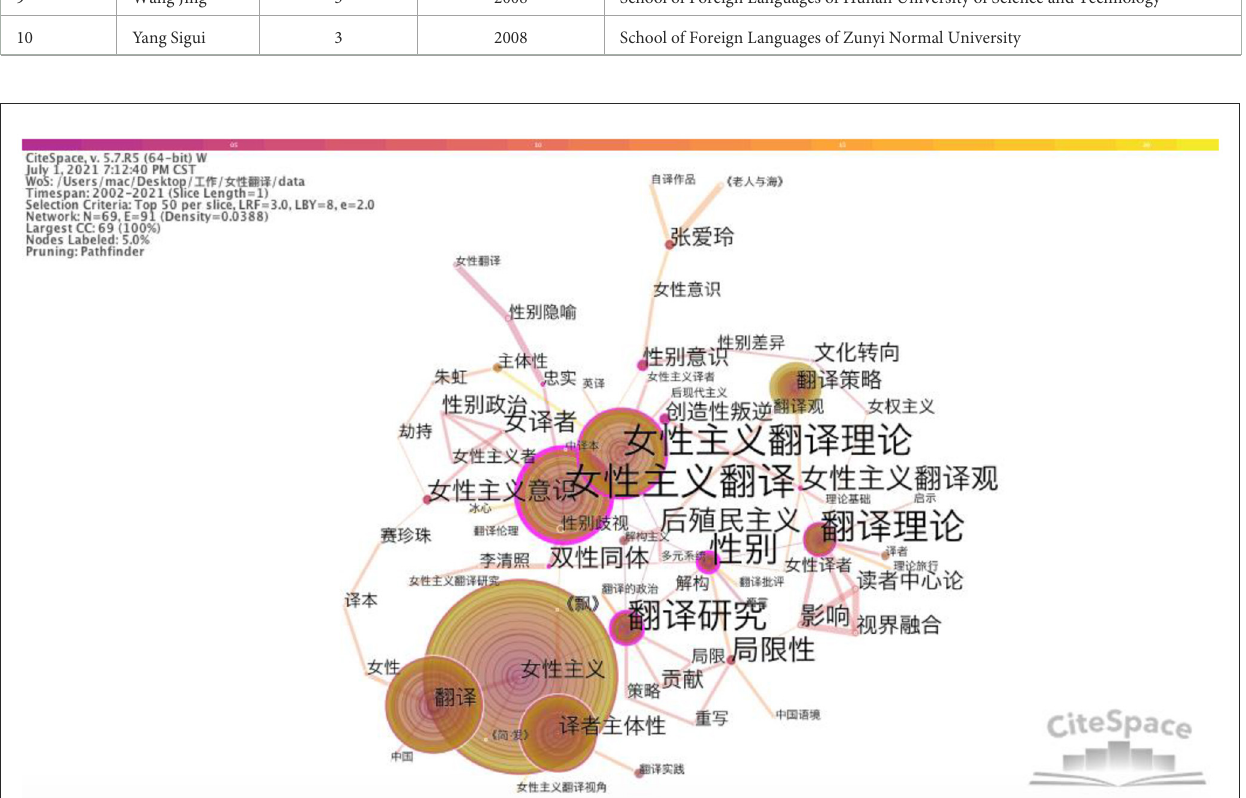
FIGURE4 Network of keywords from publications on feminist translation research in China (2002–2021).